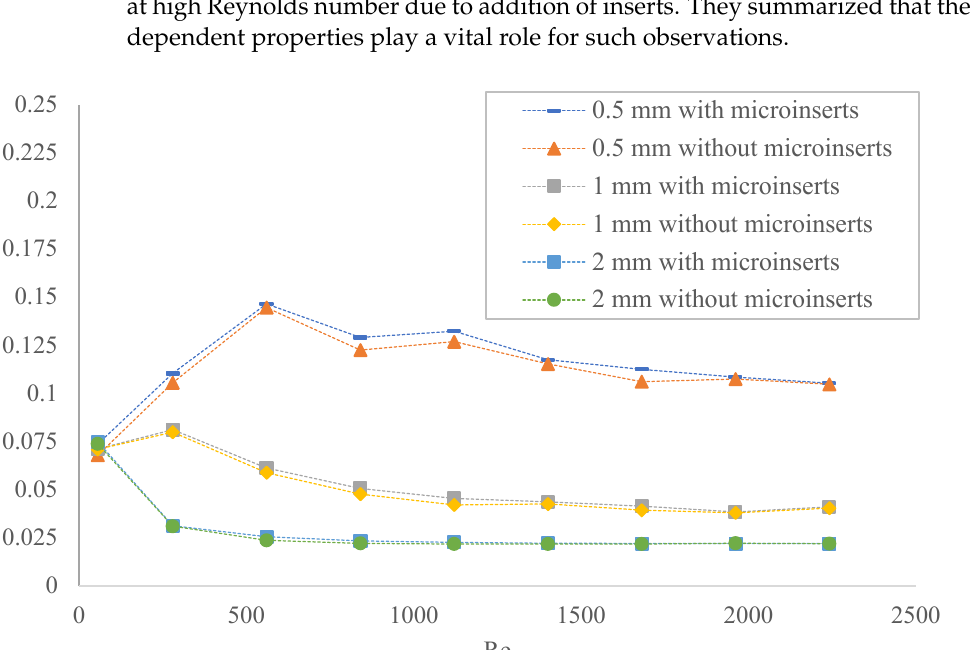
Figure 9. Variation of f/f s with Reynolds number.